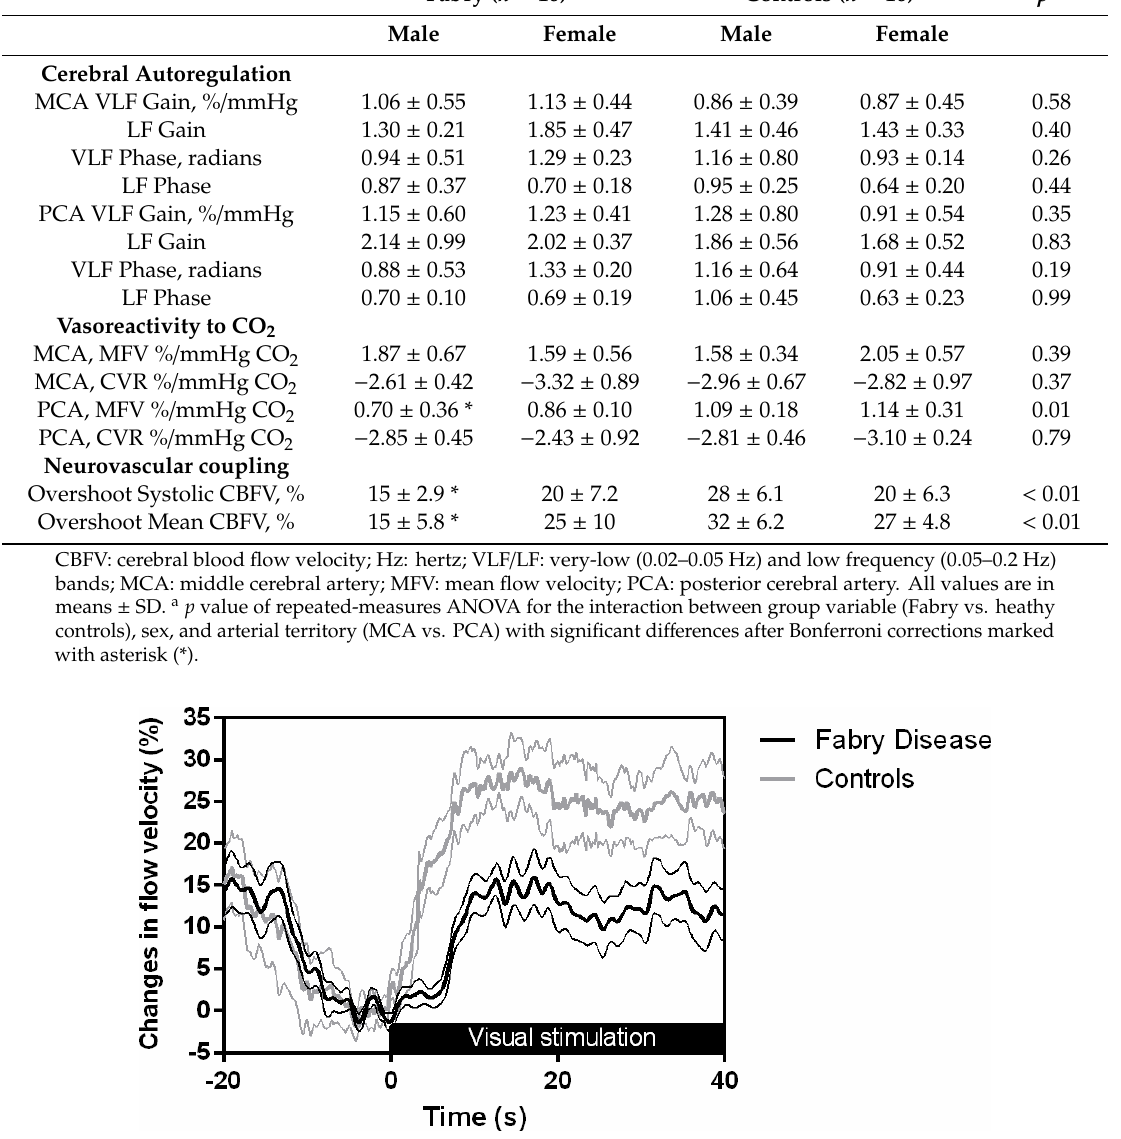
Figure 1. Group-averaged evoked systolic cerebral blood flow velocity (CBFV) responses during visual stimulation with flickering checkerboard. Male healthy controls are represented by thick lines and male Fabry disease patients by black lines. Thinner lines represent standard deviation. Table 2. Comparison of the cerebrovascular tests assessed by transcranial Doppler between Fabry disease and control groups, categorized by sex.